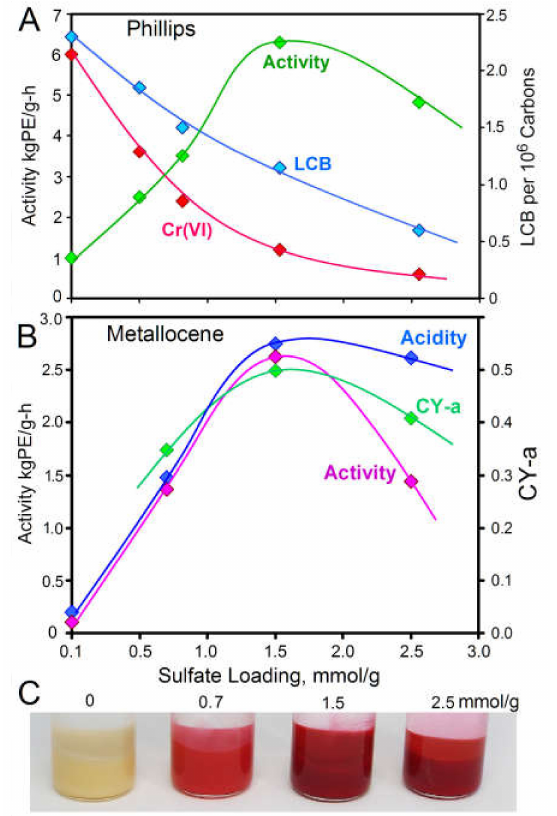
Figure 11. Activity, acidity and LCB (CY-a) from a Phillips (( A ) above) or metallocene catalyst (( B ) center) both supported on sulfated-alumina, as a function of the sulfate loading. (( C ) below), color developed by exposure to